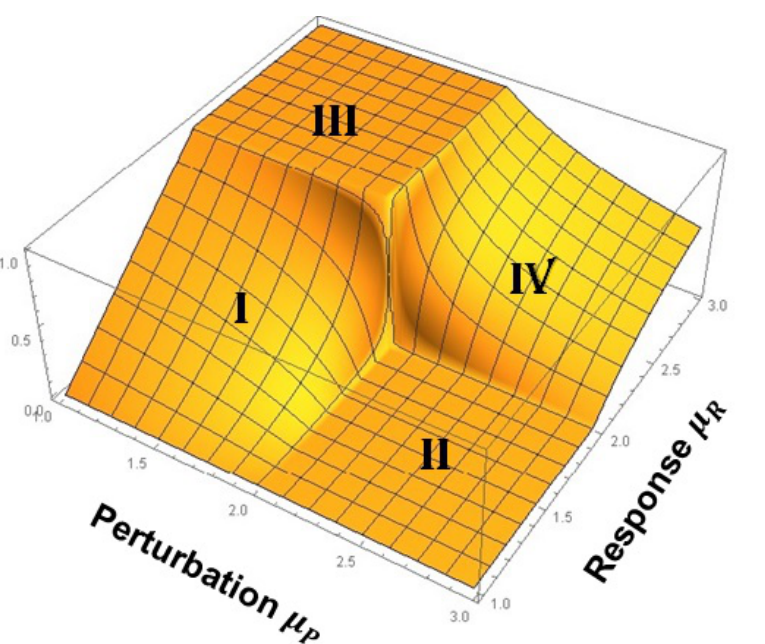
Figure 6. The cross-correlation cube (CCC) depicts the asymptotic response of the cross-correlation function, graphed as a function of the IPL indices of the responding network R and the stimulating network P. The height of the CCC, that being the vertical axis perpendicular to the ( µ R , µ P ) plane, is normalized to a maxmum value of one. Adapted from [2] with